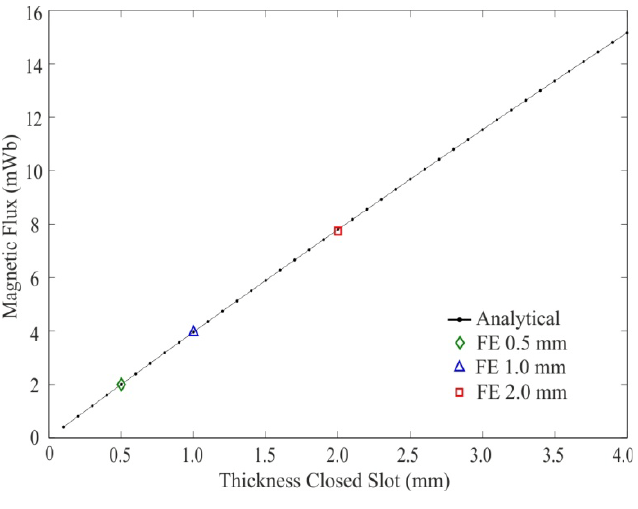
Figure 12. Peak magnetic flux through one closed slot for: 0.5 mm (diamond); 1 mm (triangle); and 2 mm (square) with FE-analysis compared with analytical results from 0.1 mm to 4 mm in